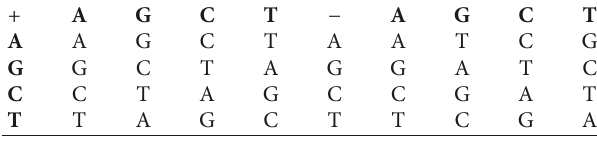
Table 2: Nucleotide computing rules under the first coding rule.